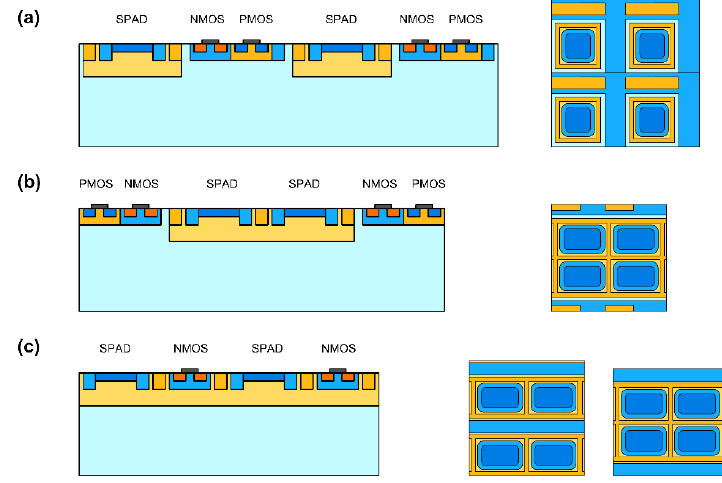
Figure 5. Cross section and 4 × 4 pixel layout of ( a ) SPADs integrated in separate deep nwell; ( b ) SPADs sharing the same deep nwell; ( c ) SPADs and NMOS transistors sharing the same deep nwell.